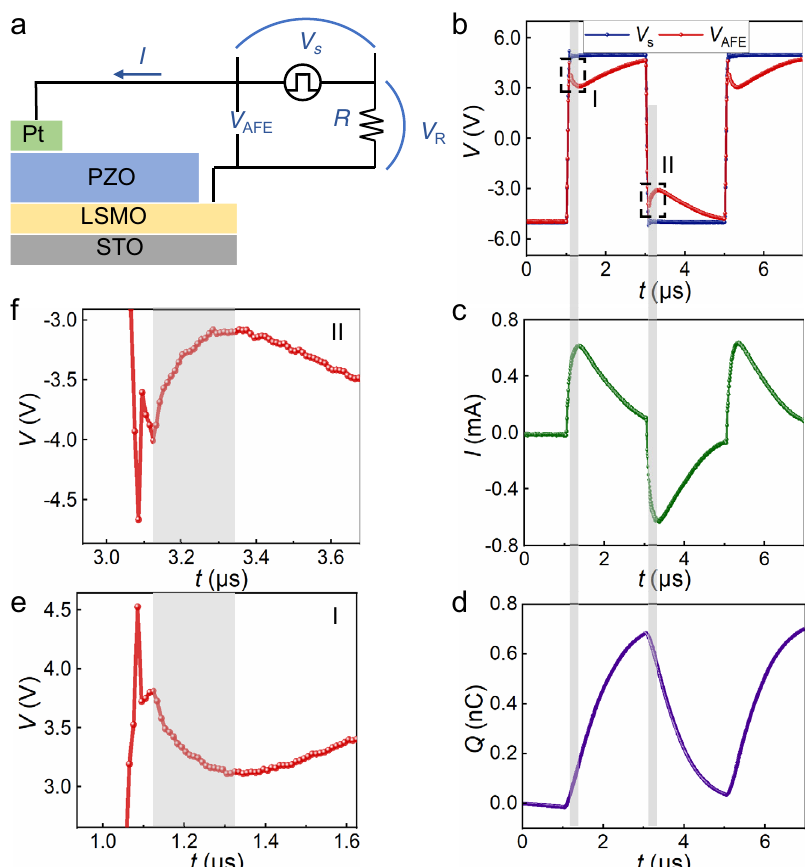
Fig. 2 Transient response of an antiferroelectric capacitor. a Schematic diagram of the experimental setup. Transients corresponding to the b source voltage V s and the antiferroelectric voltage V AFE , c current I through the circuit, d charge Q on the application of an a.c. voltage pulse V s : − 5 → + 5 → − 5 V. R = 3 k Ω . NC transients are observed at the shadow areas of the regions I and II, which are magni fi ed in e and f , respectively. The source voltage V shown as the blue line and V AFE transient as the red one in b